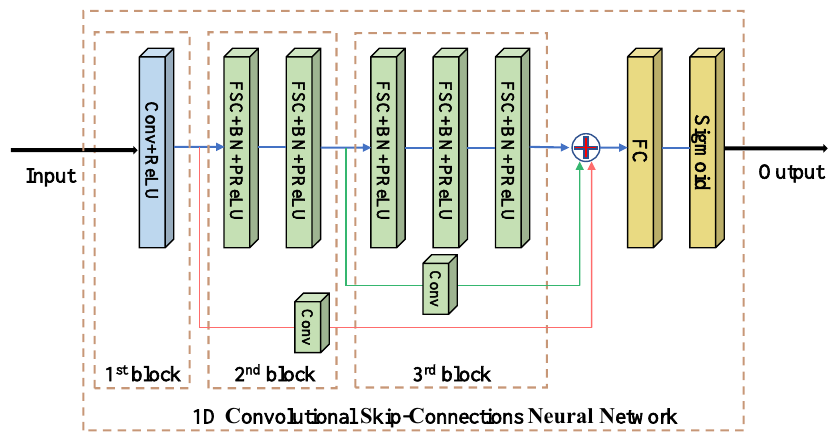
Figure 3. Schematic of the architecture of 1D-CSNN, which contains three blocks. Each block has a skip-connection line with the FC layer providing potential feature information to